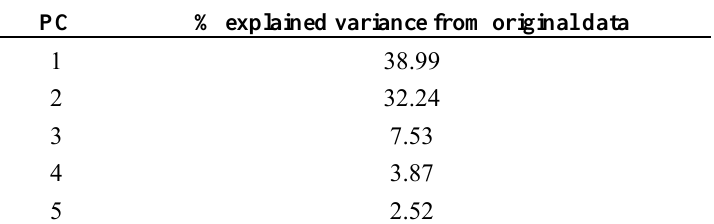
Table 2. Variance explained by CPCA.